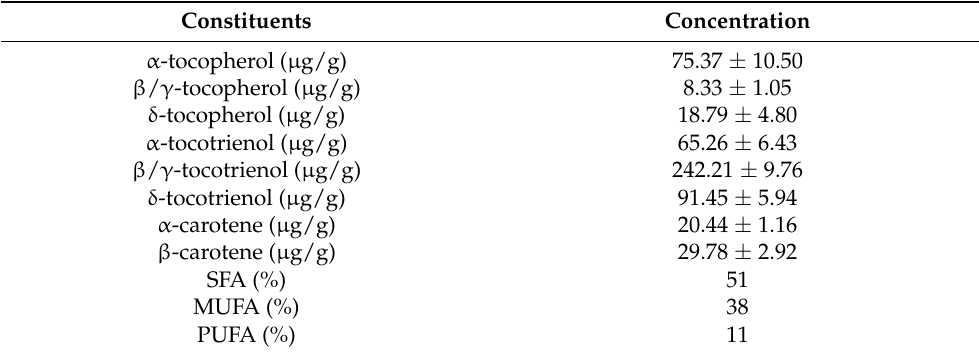
Table 2. Phytochemical and fatty acid constituent of